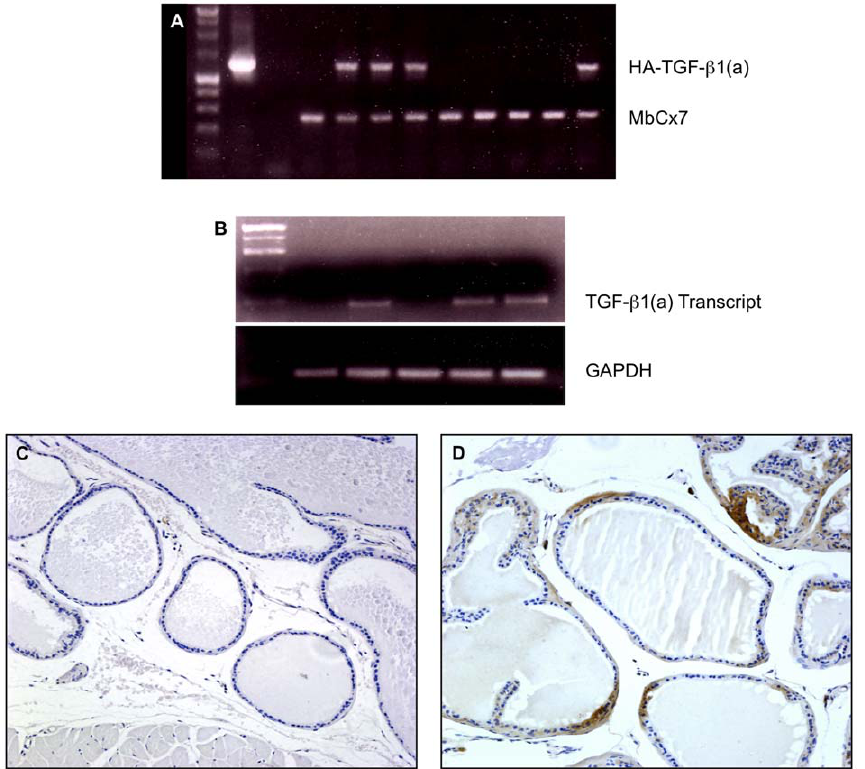
Figure 1. HA-TGF- b 1(a) transgenic expression. PanelA . Representative genomic DNA PCR screen of transgenic litters demonstrating germline transmission. PanelB. RT-PCR for transgene message in the prostate gland. GAPDH amplification serves as an internal control. PanelD. IHC of transgene demonstrates focal expression in ventral, lateral, and dorsolateral regions of secretory acini. PanelC. Wildtype acini demonstrate no immunoreactivity to HA epitope. Images C and D were captured at 6 200 magnification.